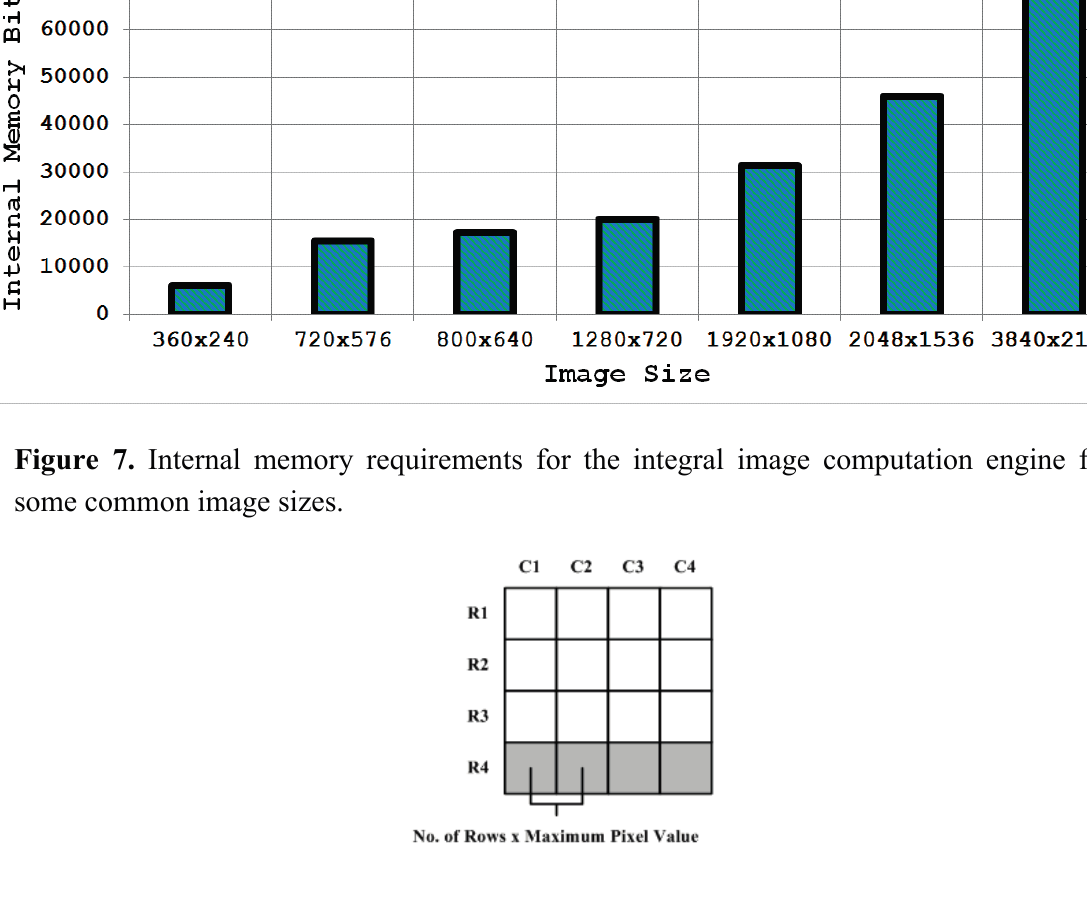
Figure 8. Worst case difference between adjacent integral image values in one